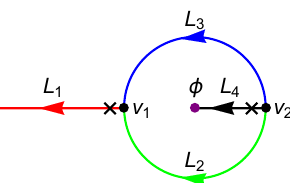
Figure 15 . \Lassoing" the defect operator (cid:30) in H L with L 1 and L 4 produces a defect operator in H L